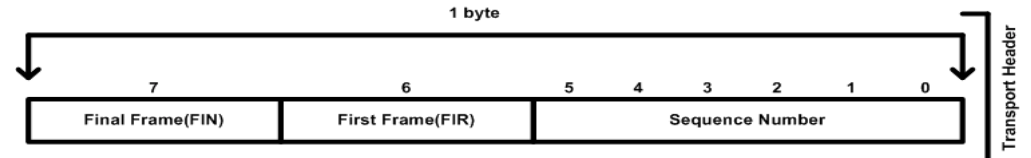
Figure 6. Transport header field structure.